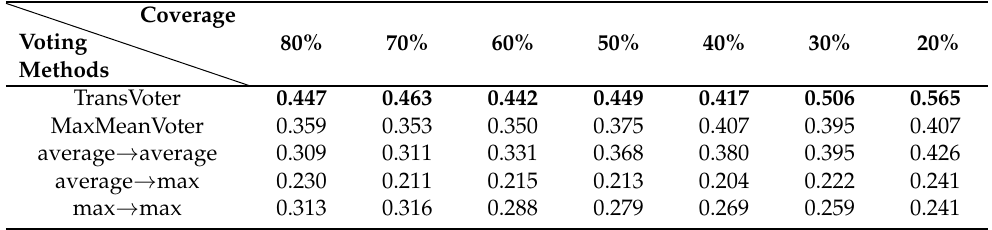
Table 6. Accuracy on re-sampled datasets through different voting methods.